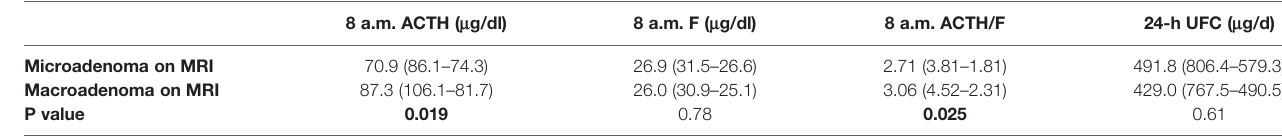
TABLE 3 | Comparison of investigations of the PA axis between microadenoma and macroadenoma.